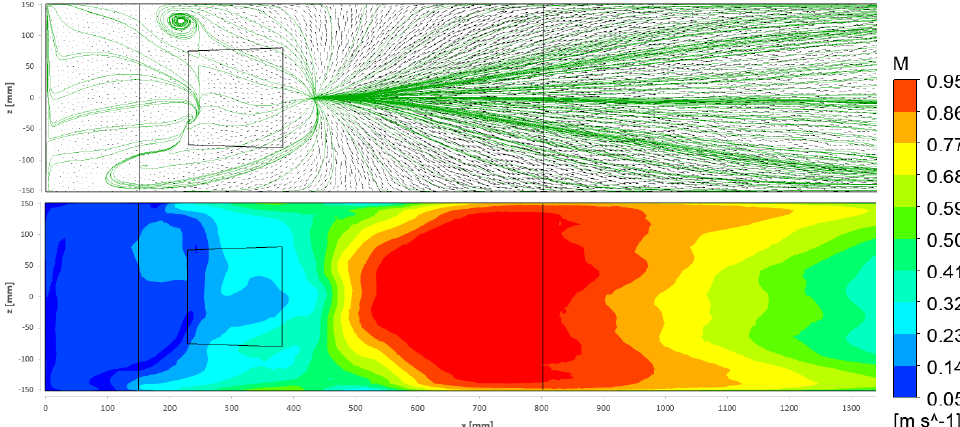
Figure 23. Finite volume method (SAS model), vector lines ( top ) and the magnitude of time-averaged 2D velocity ( bottom ) in horizontal plane ( y = 10mm ) .